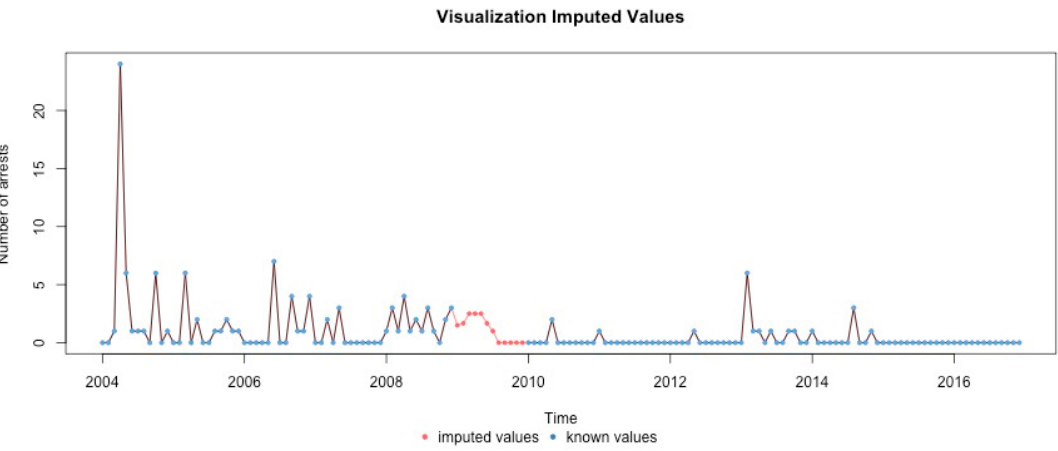
Figure A22. Heroin organized Czech nationals crime arrests 2004–2016 in the Czech Republic – imputed missing values.